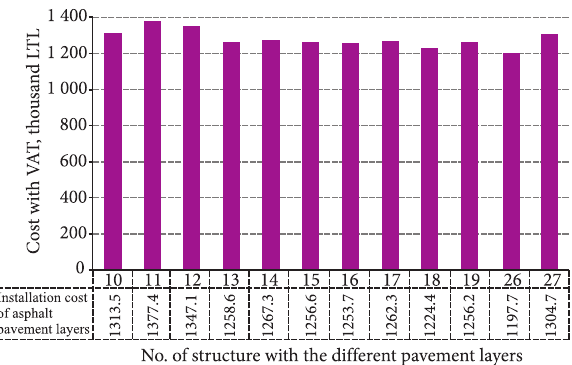
fig. 5. Distribution of construction costs (1 Euro = 3.44 LTL) of all three asphalt pavement layers according to the materials used